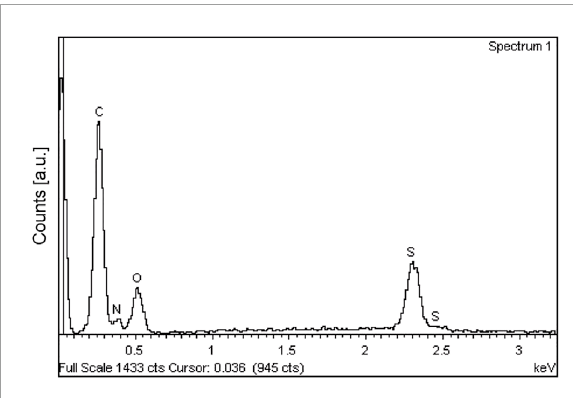
FIGURE 5 An EDX spectrum recorded from the untreated cashmere fabric sample with its majority